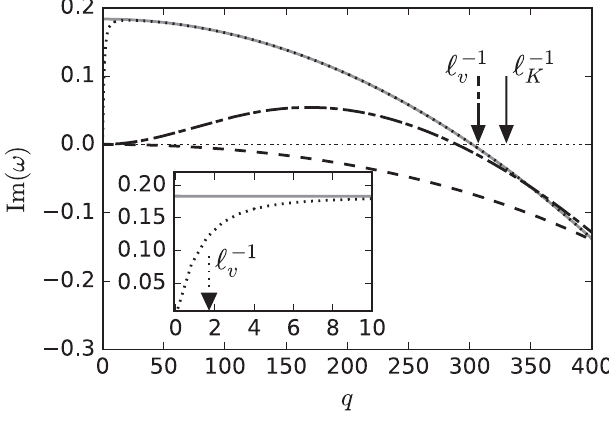
FIG. 2. Growth rate versus wave number. Gray line, Stokesian limit; black dotted line, O ð q Þ unstable, l v ¼ 1 , and R ¼ 5 × 10 − 2 ; black dash-dotted line, O ð q 2 Þ unstable, ¼ 3 × 10 − 3 , and R ¼ 4 . 5 × 10 3 ; black dashed line, stable, l v ¼ 3 × 10 − 4 , and R ¼ 4 . 5 × 10 5 . Arrows indicate the wave l v number corresponding to l v for the unstable cases. For all the dispersion curves, we use ϕ ¼ 55 ° and K ¼ 10 − 6 , which sets ¼ 3 . 2 × 10 − 3 l K